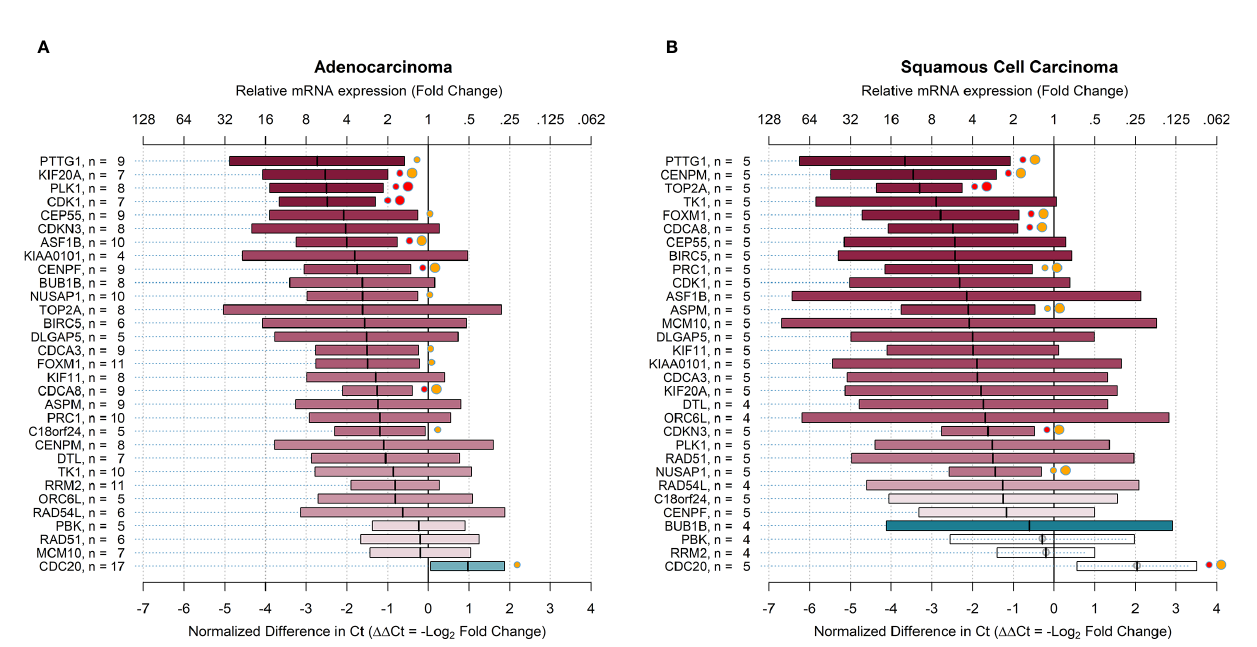
FIGURE 3 | Relative mRNA expression of target genes in ALDH high cells compared to ALDH low cells in all stages of adenocarcinoma and squamous cell carcinoma. The plots show relative mRNA expression measures of 31 recurrence genes, comparing ALDH high to ALDH low cells populations. The red color of boxes indicates a higher expression in ALDH high cells, whereas the blue color indicates a higher expression in ALDH low cells. (A) all stages adenocarcinoma; (B) all stages squamous cell carcinoma. Ct = cycle thresholds. DD Ct = Delta Delta Ct (normalized difference in Ct). The mid-points of the boxes are the punctual estimates and the boxes represent the 95% con fi dence intervals (not adjusted for multiple comparisons). The level of statistical signi fi cance is reported as red (p < 0.01) or orange (p < 0.05) circles next to the boxes. Small circles represent raw p-values, whereas large circles represent Benjamini-Hochberg-corrected p-values (i.e. with false discovery rate (FDR) correction). There were 12 (38.7%) target genes that were signi fi cantly overexpressed in adenocarcinoma and 6 (19.4%) genes overexpressed in squamous cell carcinoma. When the FDR correction was applied for multiple comparisons, the number of overexpressed genes declined to 9 (29.0%) in adenocarcinoma and 9 (29.0%) in squamous cell